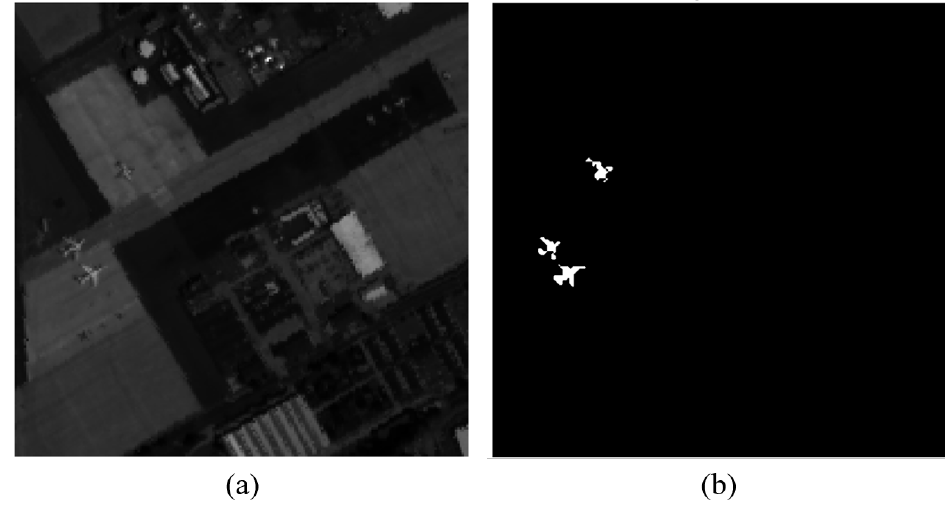
Figure 4. ( a ) The first band of the AVIRIS San Diego hyperspectral image. ( b ) Ground truth location of the